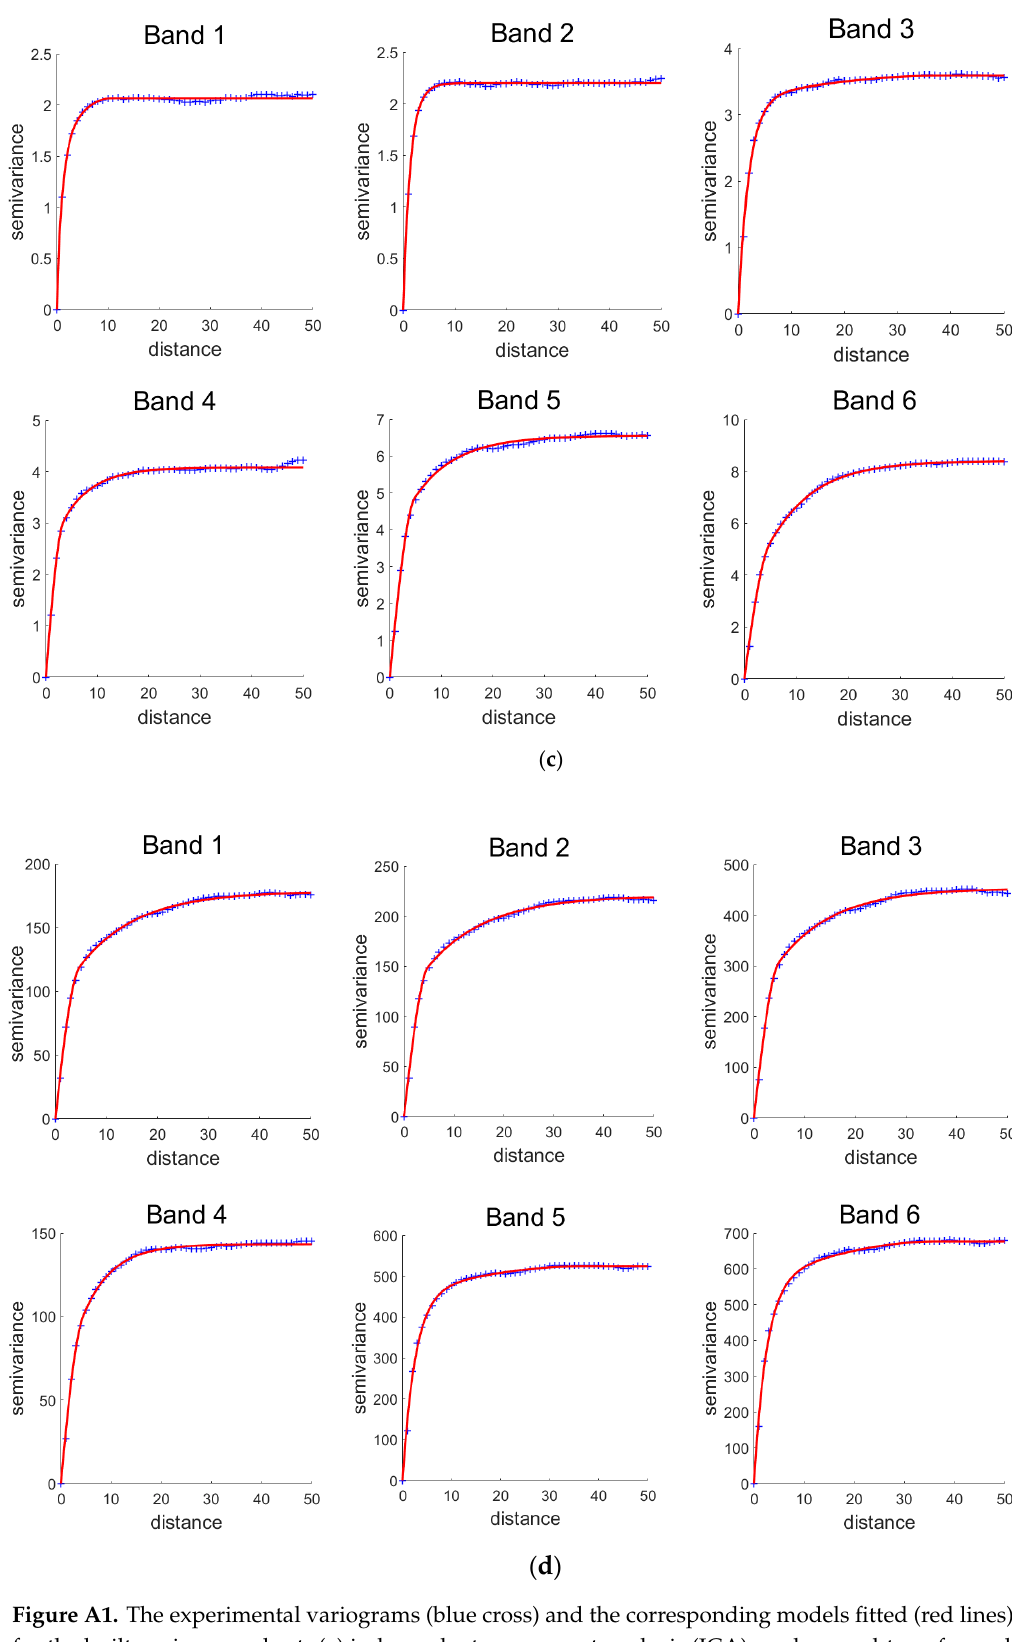
Figure A1. The experimental variograms (blue cross) and the corresponding models fitted (red lines) for the built-up image subset: ( a ) independent component analysis (ICA)- and normal-transformed image bands ( Z (cid:48)(cid:48) ), ( b ) ICA-transformed image bands ( Z (cid:48) ), ( c ) maximum noise fraction (MNF)-transformed image bands ( Z (cid:48) ), and ( d ) original image bands ( Z